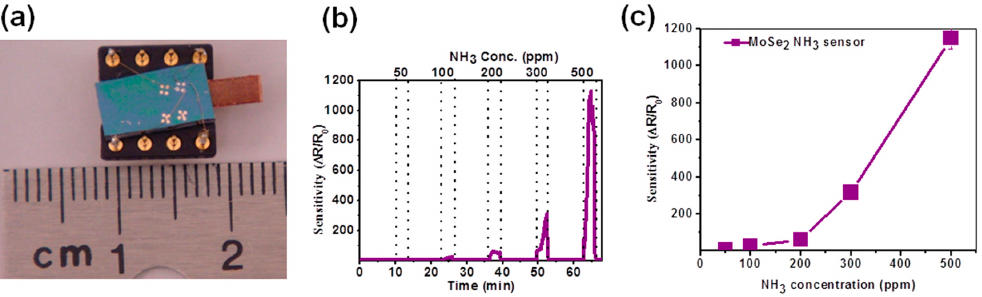
Figure 11. ( a ) Optical image gas of MoSe 2 sensor device; ( b ) NH 3 sensing response as function of gas concentration; and ( c ) linear plot of sensitivity of MoSe2 gas sensor device as a function of NH3 gas concentration (ppm). Reprinted with permission from [88]. Copyright (2014) AIP Publishing LCC: Melville, NY,